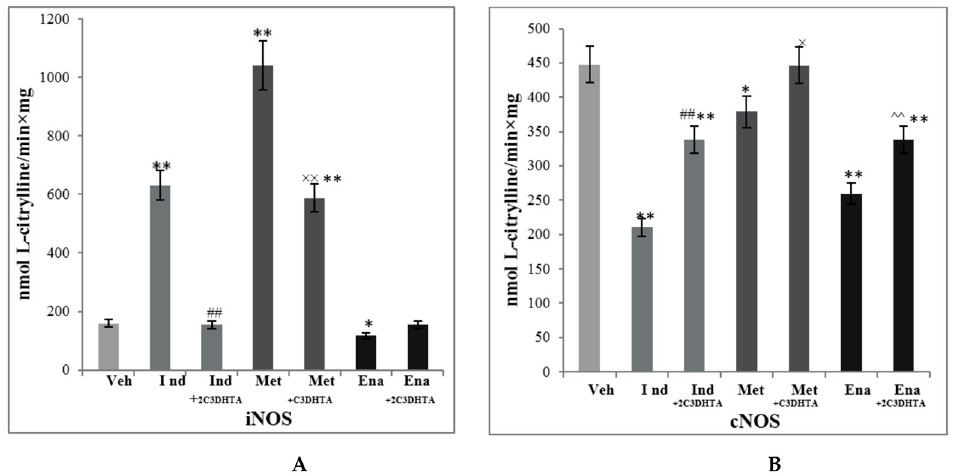
Figure 4. Effect of 2C3DHTA activity of nitric oxide synthases (iNOS—( A ) and cNOS—( B )) in homogenates of small intestinal mucosa at the background of drug-induced enteropathy of rats of the following groups: group 1—control group (Veh), group 4—indomethacin-induced enteropathy